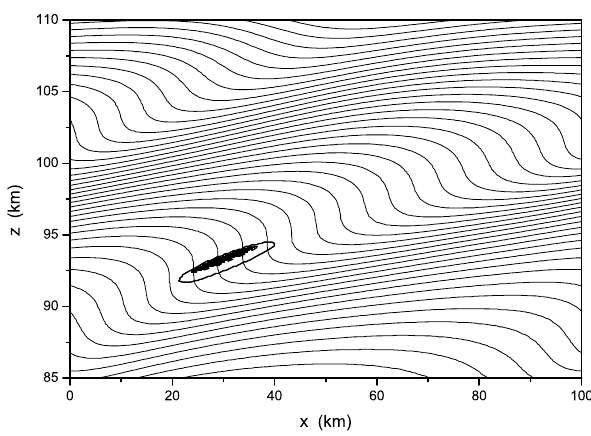
Fig. 1. Contour plot of the total potential temperature and Richard- son number when a GW becomes